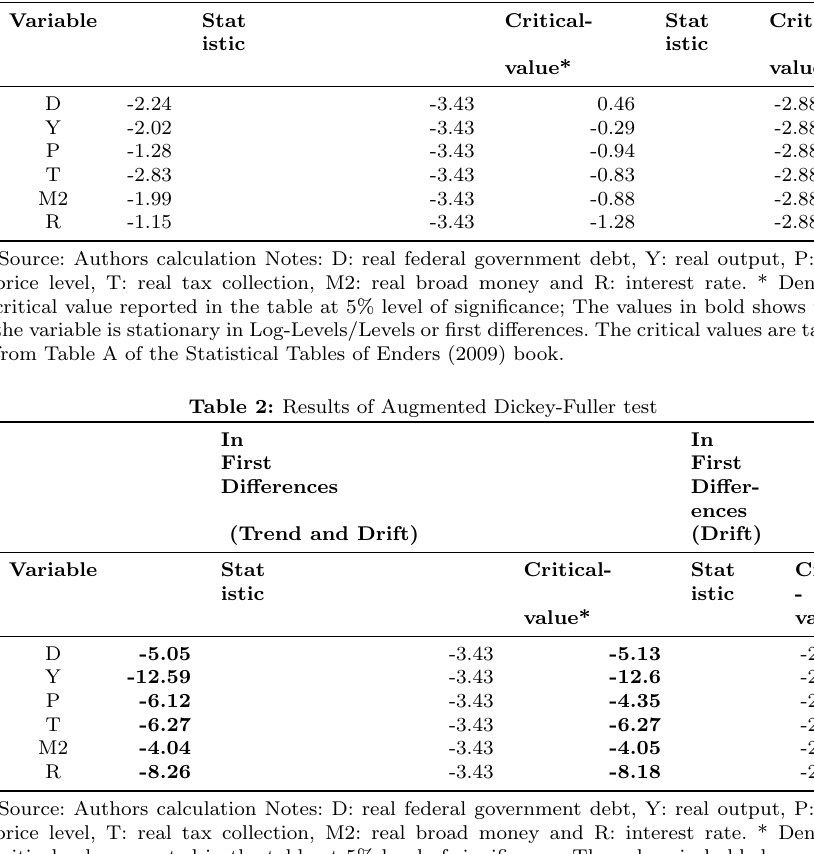
Table 1: Results of Augmented Dickey-Fuller test in Levels/Log-Levels In Levels /Log- Levels (Trend and Drift) (Drift) Variable Stat istic